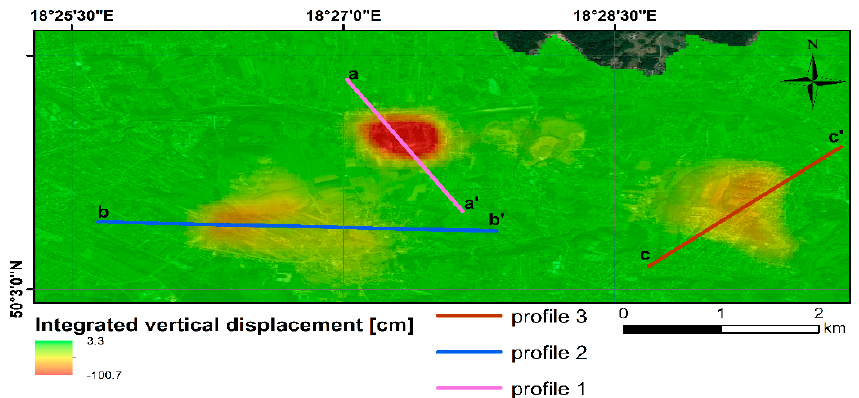
Figure 12. Subsidence bowl with three profiles extracted for DInSAR and SBAS comparison.